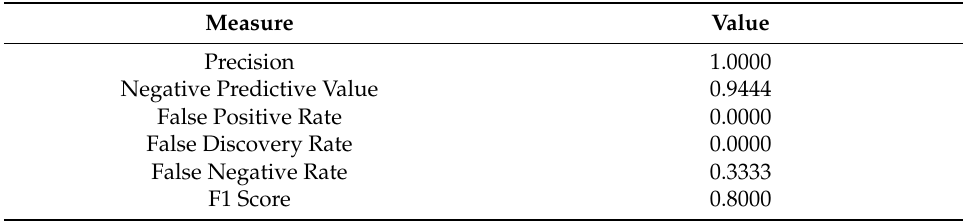
Table 2. The performance of IIoTMS classifier.